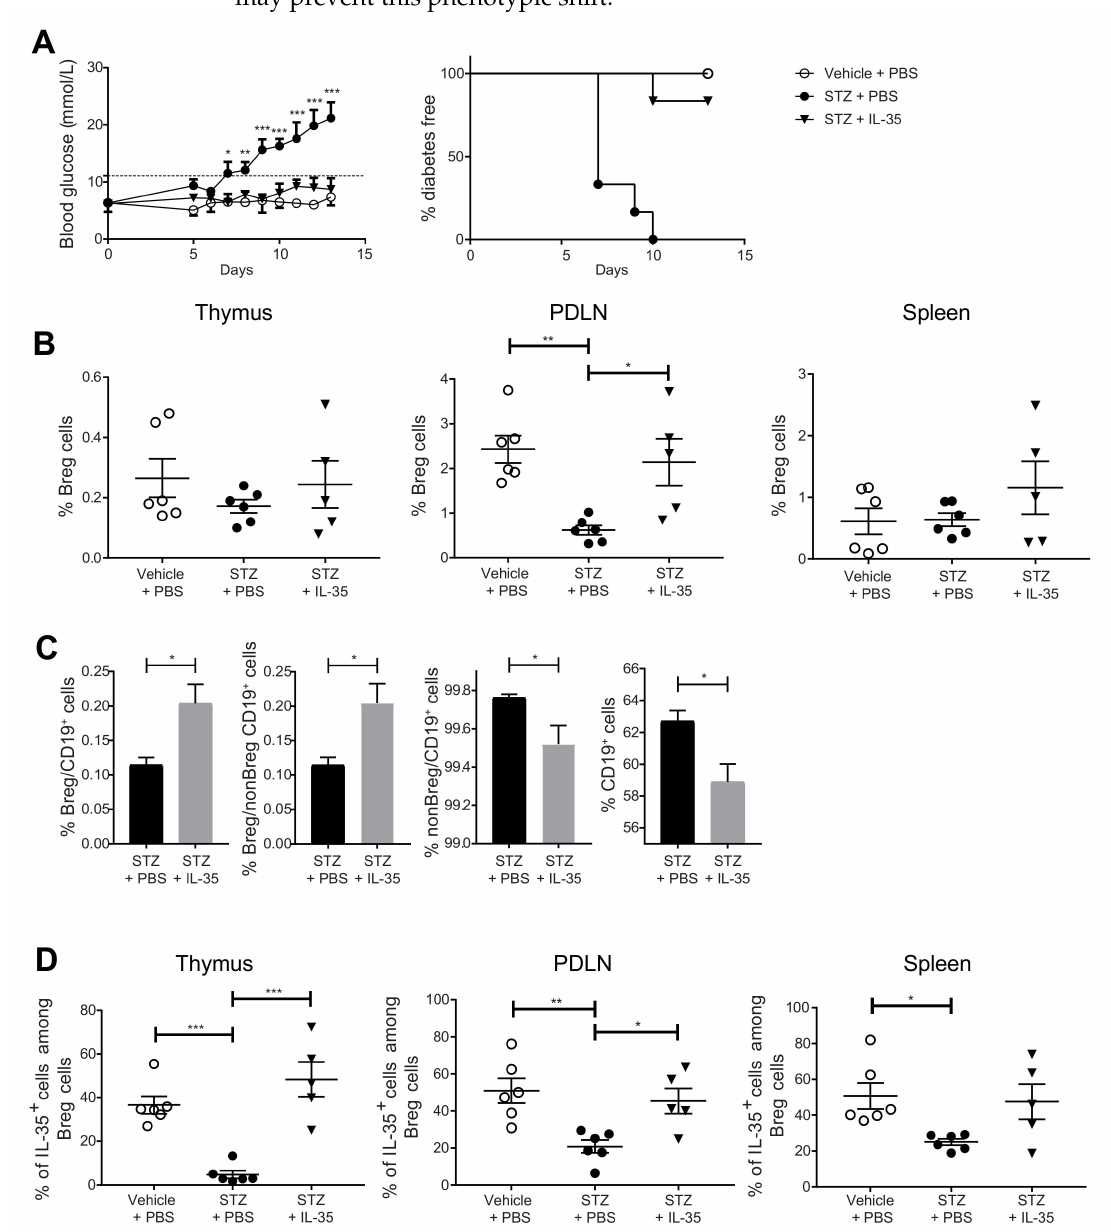
Figure 4. IL-35 treatment prevents hyperglycemia in the MLDSTZ mouse model and reverses the decreased Breg cell proportions. Male CD-1 mice were injected with saline or low doses of STZ for 5 consecutive days. For the next 8 days, mice received saline further, were injected daily with PBS, and STZ mice were injected daily with PBS or recombinant mouse IL-35 (0.75 µ g/day). Blood glucose levels of the mice were measured every day from day 5 after the first STZ injection, and the percentages of diabetes-free mice were measured. ( A ) The mice were killed on day 13. Single cells were prepared from removed thymic glands, PDLNs, and spleens. The proportions of ( B ) CD19 + CD1d + CD5 + Breg cells, ( C ) Breg cells among CD19 + cells and CD19 + cells, and ( D ) IL-35 + cells among CD19 + CD1d + CD5 + Breg cells were determined by flow cytometry. Results are expressed as means ± SEM from two experiments ( n = 2–3 mice/group/experiment). Repeated two-way ANOVA followed by Dunnett’s test, one-way ANOVA followed by Tukey’s test, and unpaired t -tests were performed for comparisons. *, **, and *** denote p < 0.05, p < 0.01, and p < 0.001,